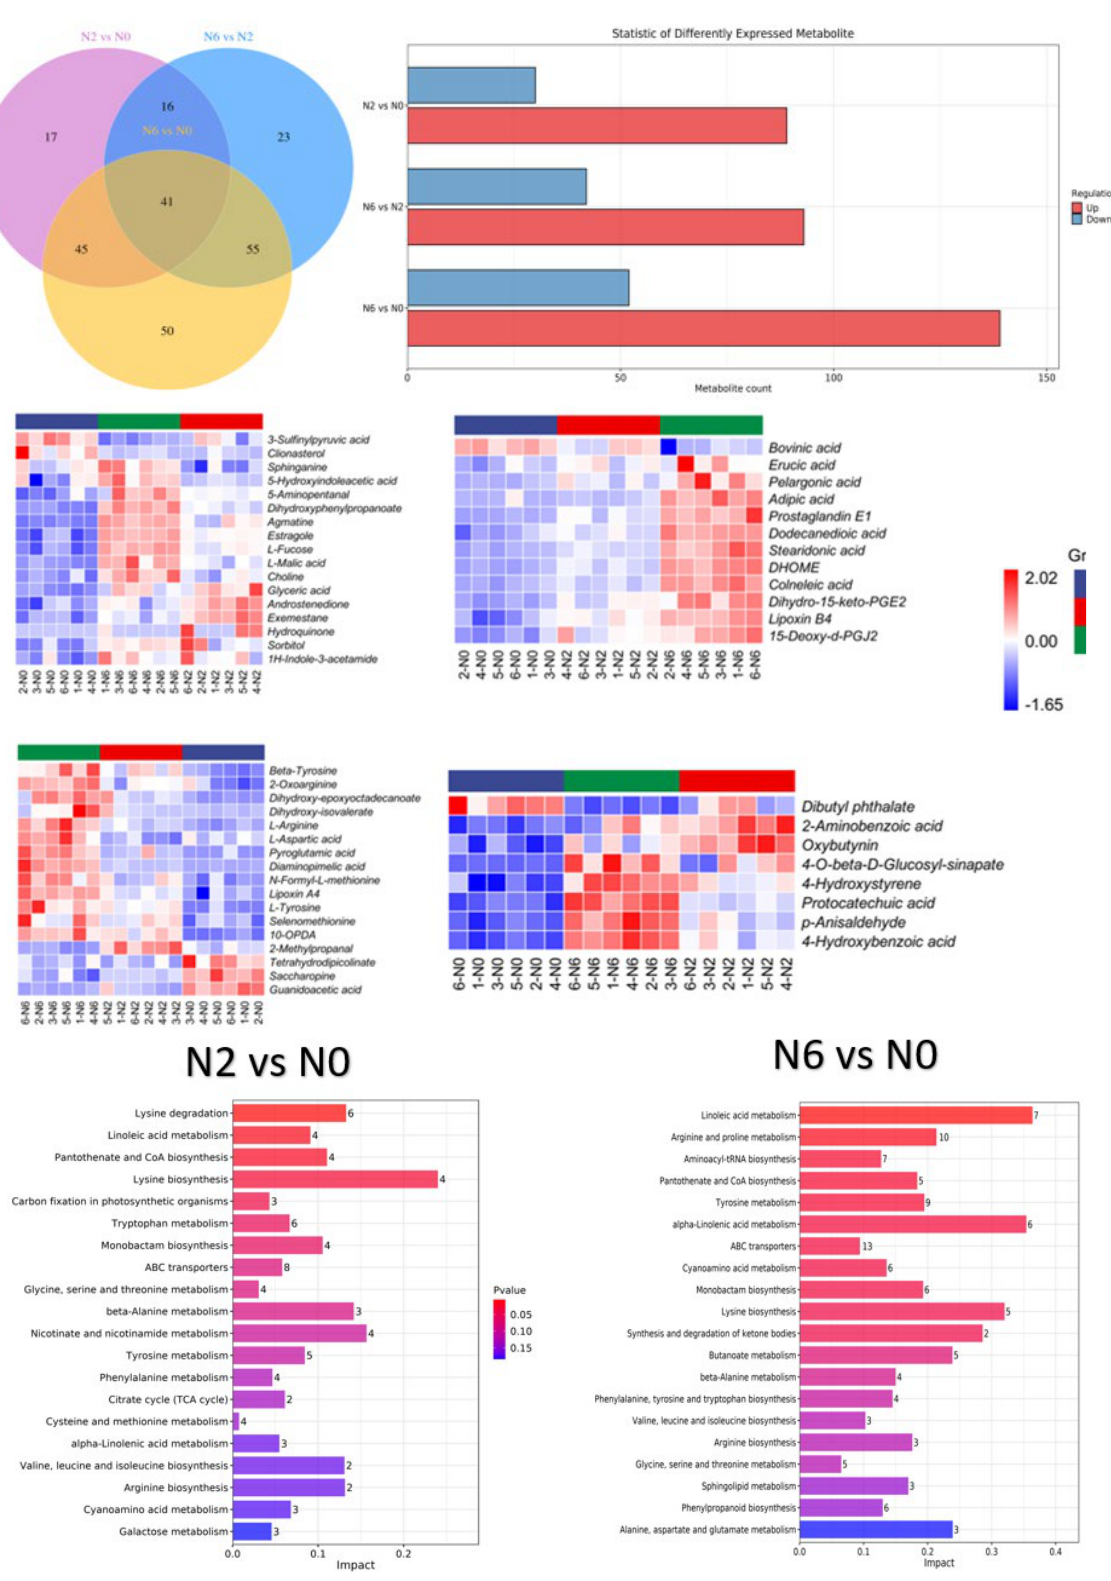
Figure 3. Venn diagram and statistics of differently expressed metabolite, KEGG enrichment bar chart.